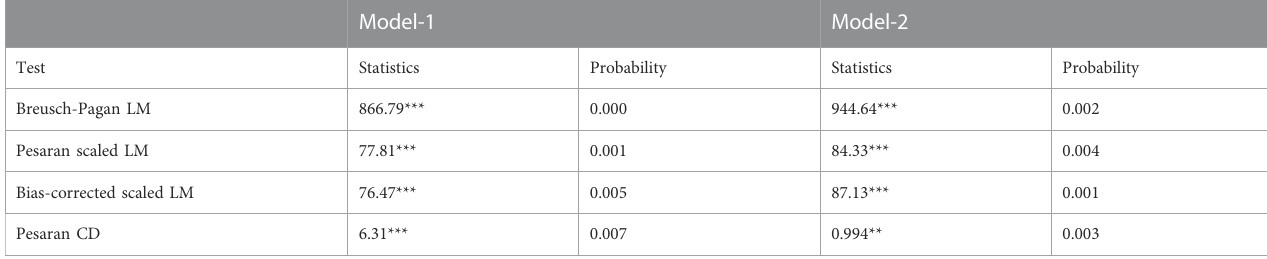
TABLE 2 Results of cross-sectional dependency